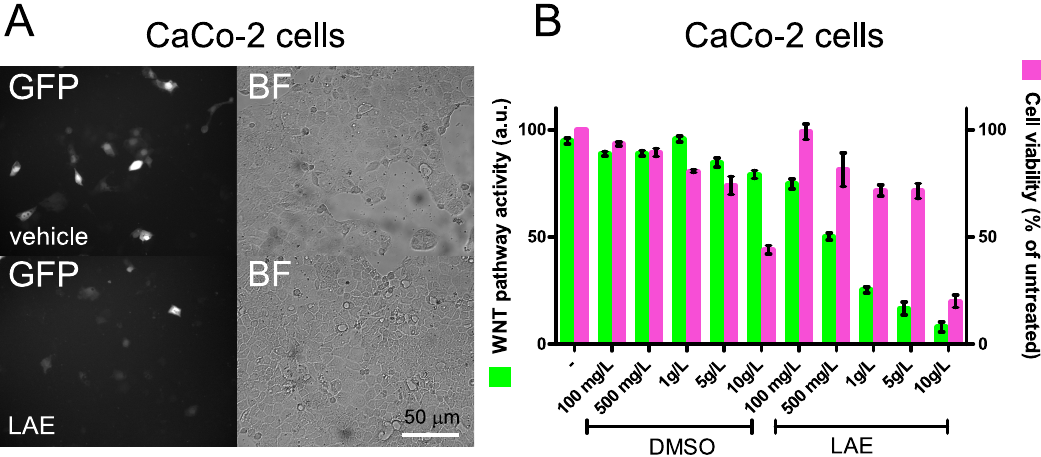
Figure 4. AAE and LAE act as WNT inhibitors in CaCo-2 cells. ( A ) Activity of the WNT reporter construct TCF-wt GFP in CaCo-2 cells cultivated for 48 h in the presence or in the absence of LAE (400 mg/L) (representative of five experiments) (BF = Bright Field; scale bar is shown); ( B ) WNT pathway activity (green bars) and cell viability (magenta bars) of CaCo-2 cells transfected with TCF-wt GFP and cultivated in the absence ( − ) or in the presence of the indicated concentration of LAE (or of the corresponding dilution of DMSO). Values on the left axes indicate changes in GFP expression (a.u.). Values on the right axes indicate changes in cell viability expressed as percentage of untreated cells ( −